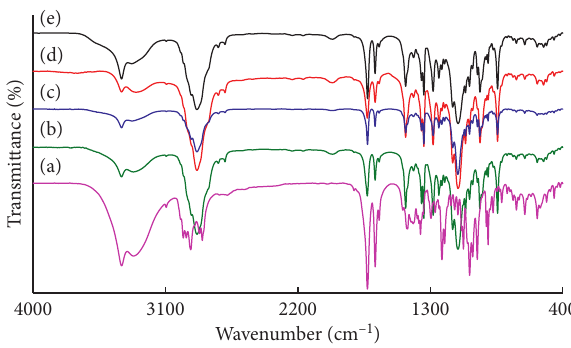
Figure 1: FT-IR spectra of (a) pure AG, (b) AG-PEG4000 pal- mitate-PM, (c) AG-PEG4000 palmitate-SD, (d) AG-PEG8000 palmitate-PM, and (e) AG-PEG8000